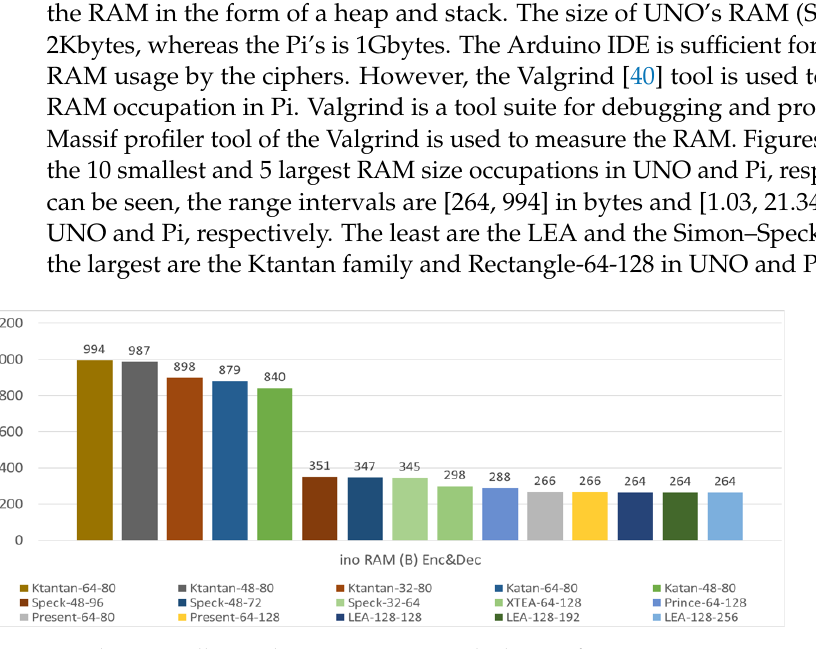
Figure 6. The 10 smallest ciphers RAM usage and 5 largest for UNO.